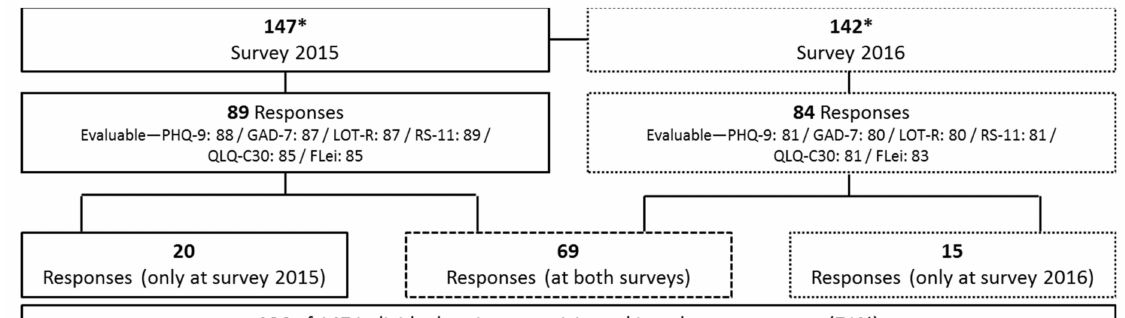
Figure 1. Patient recruitment and response rates in two surveys of the cohort of autoimmune thrombotic thrombocytopenic purpura (iTTP) patients from Mainz. A total of 147 eligible iTTP patients in remission were invited to fill in the various questionnaires used in two surveys each (2015 and 2016). * Between the first and second survey five patients were lost to